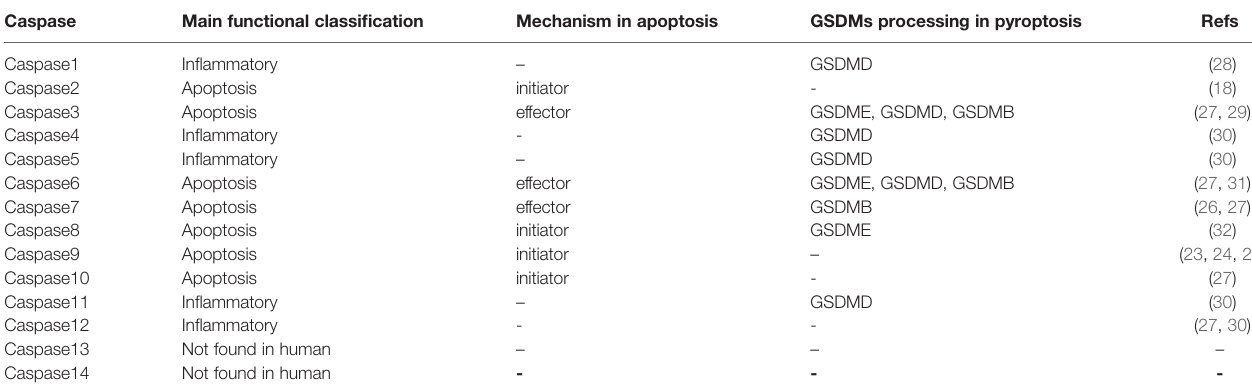
TABLE 1 | The role and mechanism of Caspase family in Apoptosis and